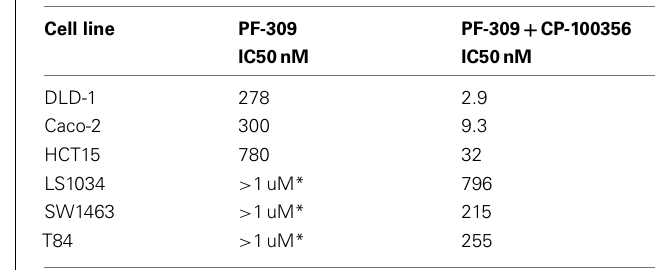
Table 2 | Inhibition of P-gp increases potency of PF-309.